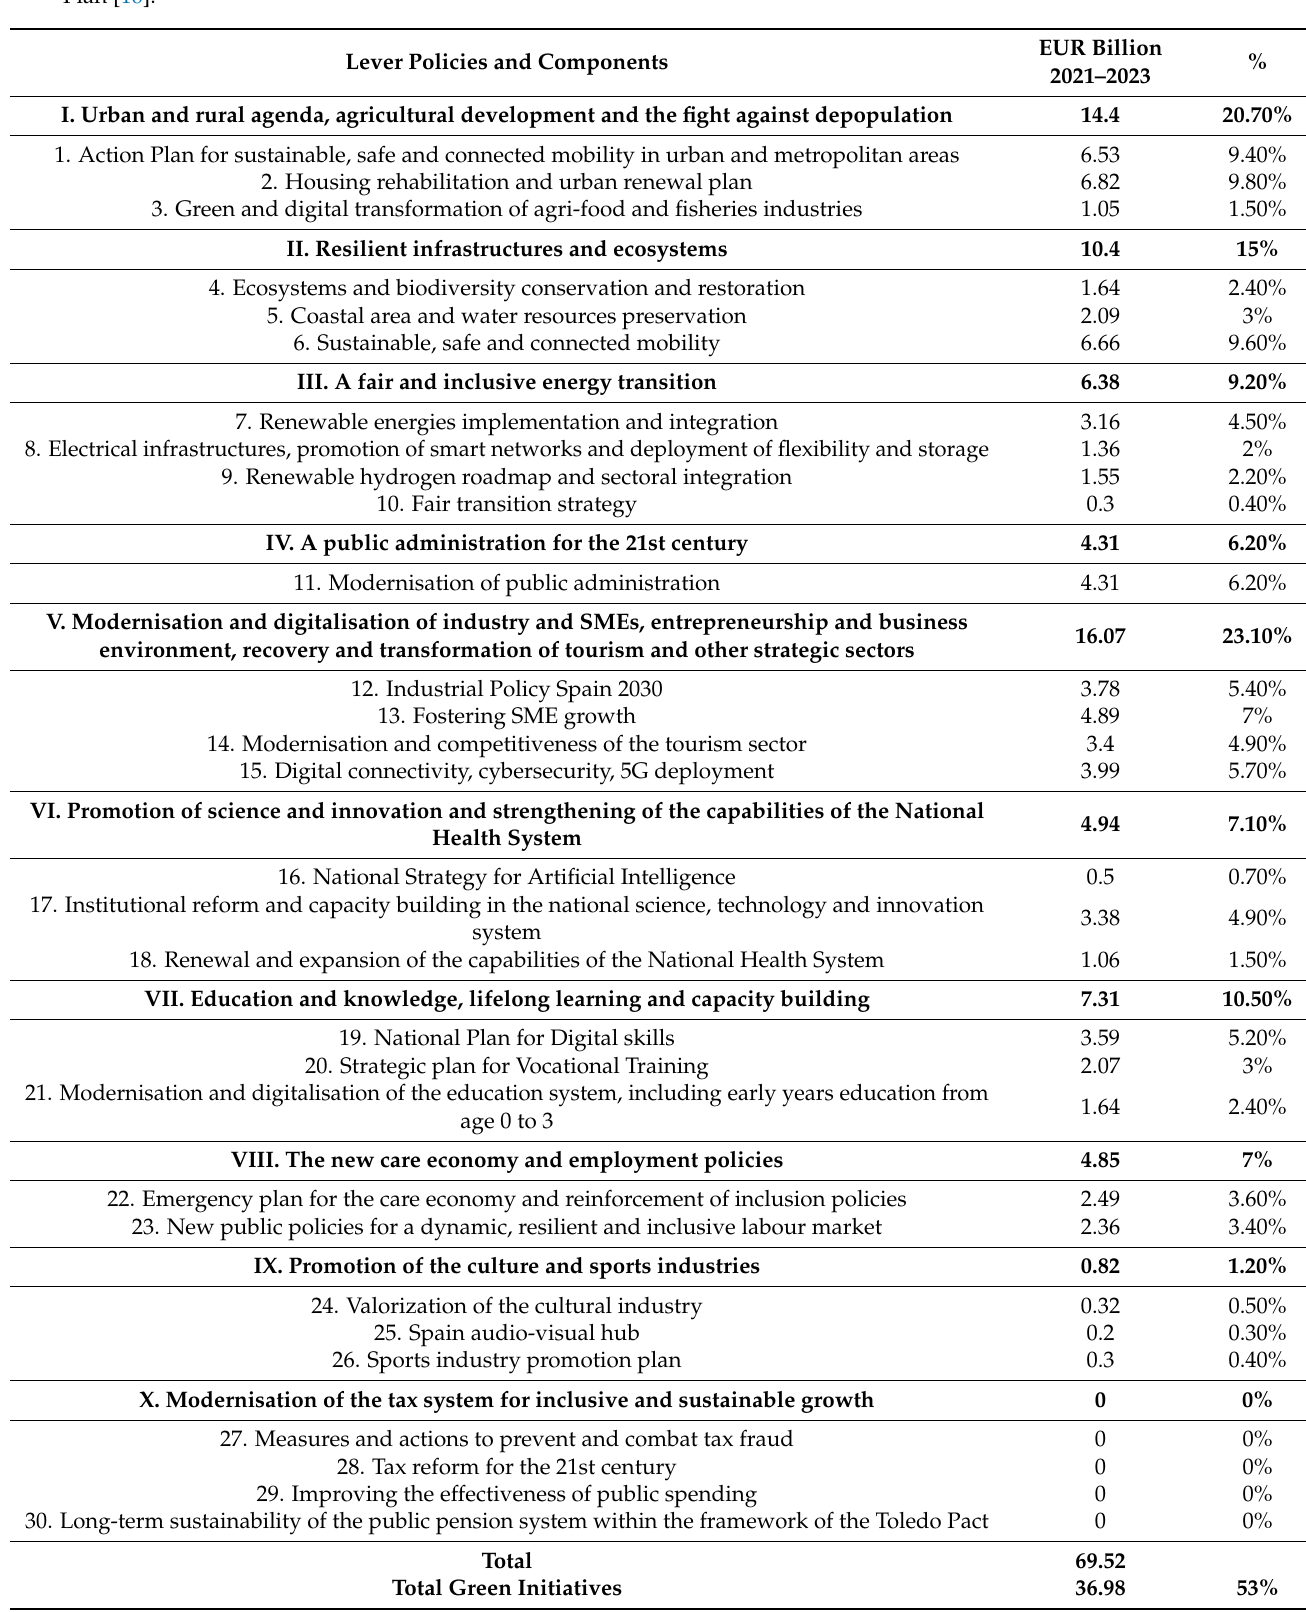
Table 2. Recovery plan sections and investments. Source: own elaboration based on data from the Spanish Recovery Plan